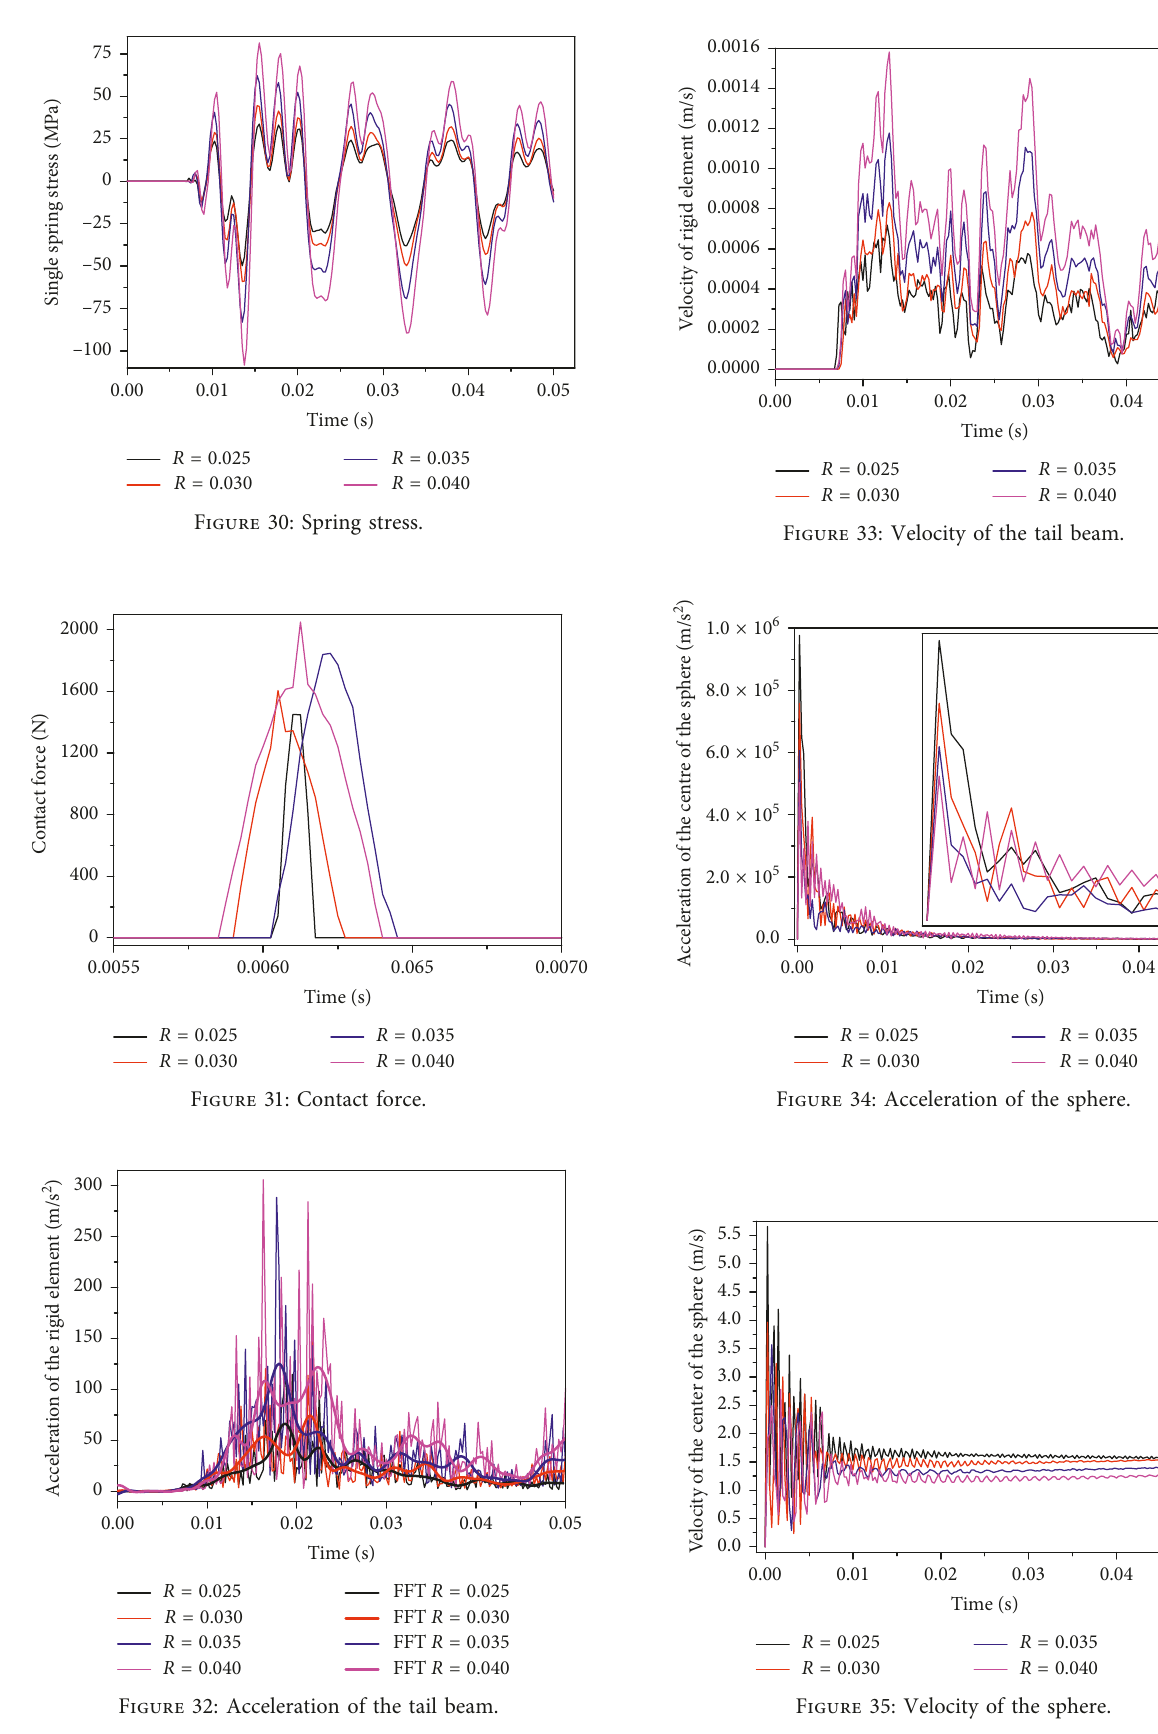
Figure 35: Velocity of the